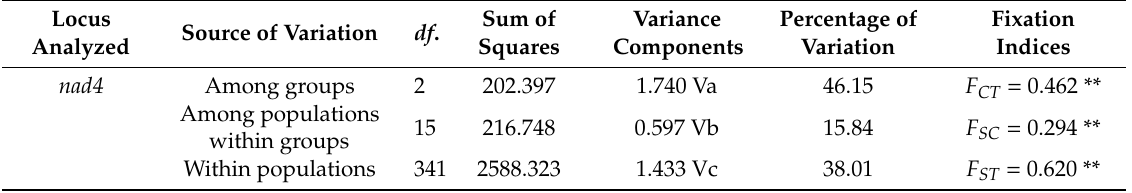
Table 3. Partitioning of genetic variation at di ff erent hierarchical levels.